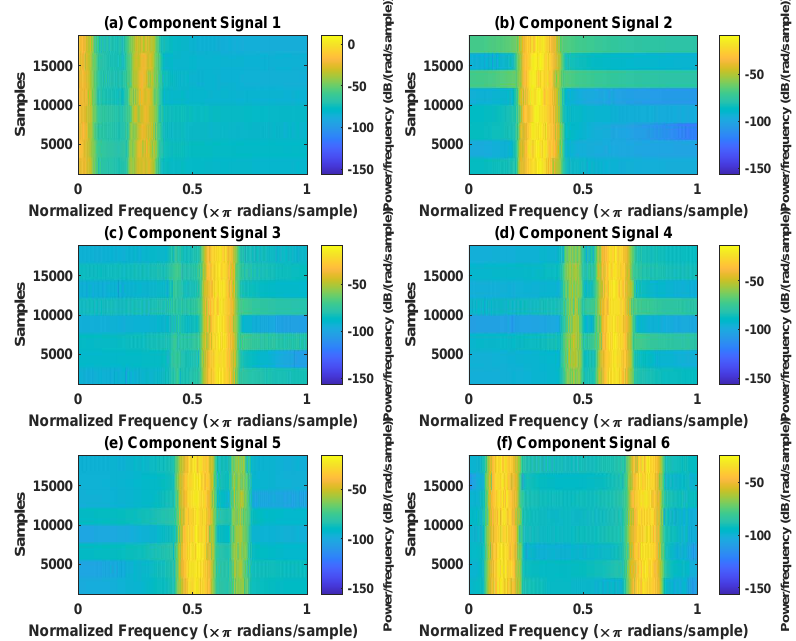
Figure 8. Decomposition results of FESVDP with m = 16 and J = 3: ( a – f ) time–frequency diagram of 1st to 6th subcomponents,